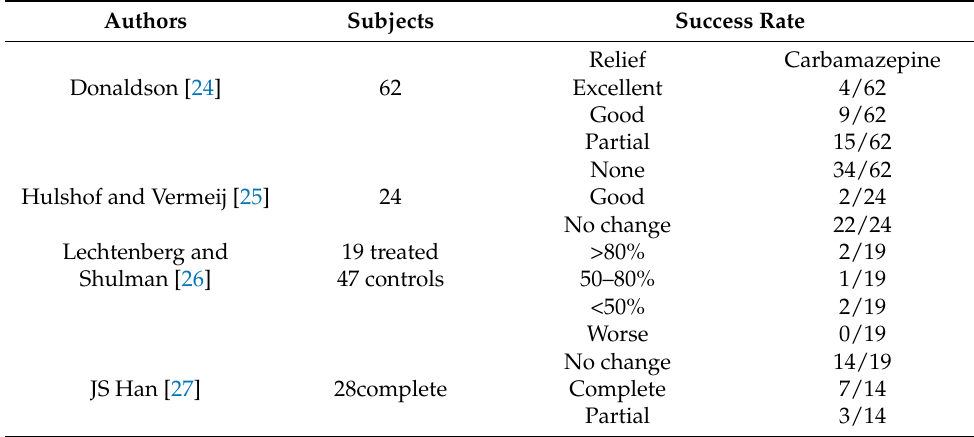
Table 4. Summary of studies that used carbamazepine to treat